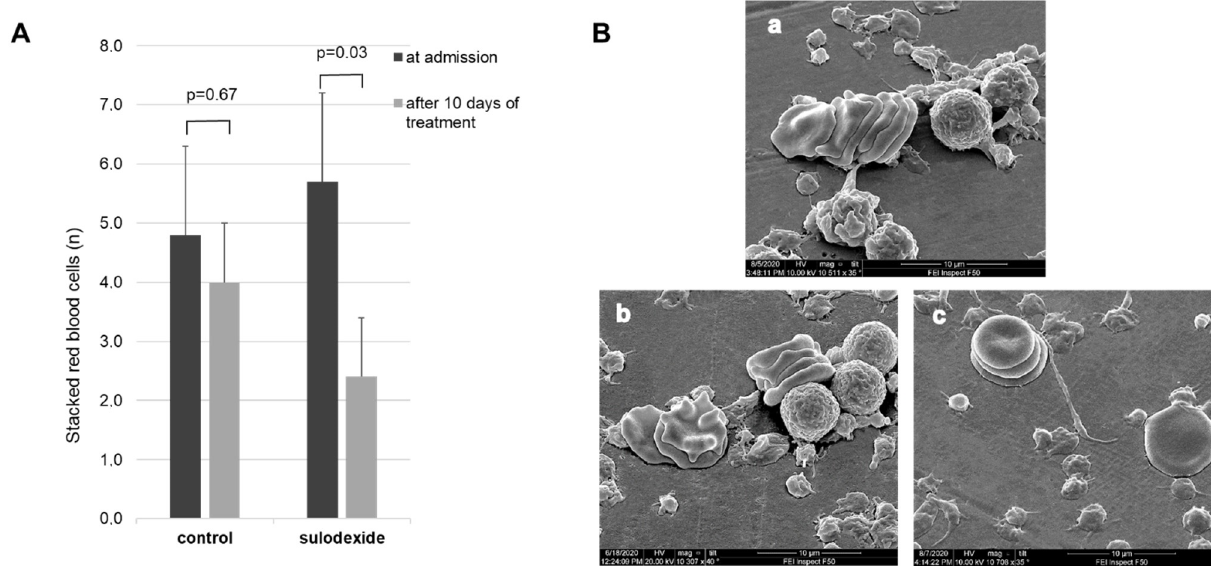
Figure 2. ( A ): Effect of routine treatment and treatment including sulodexide on the quantity of erythrocytic sludges in venous blood of patients with COVID-19. ( B ): Microphotographs of blood specimens on admission ( a ) and after 10 days of treatment in control ( b ) and experimental ( c ) groups. Magnification ×10.000.